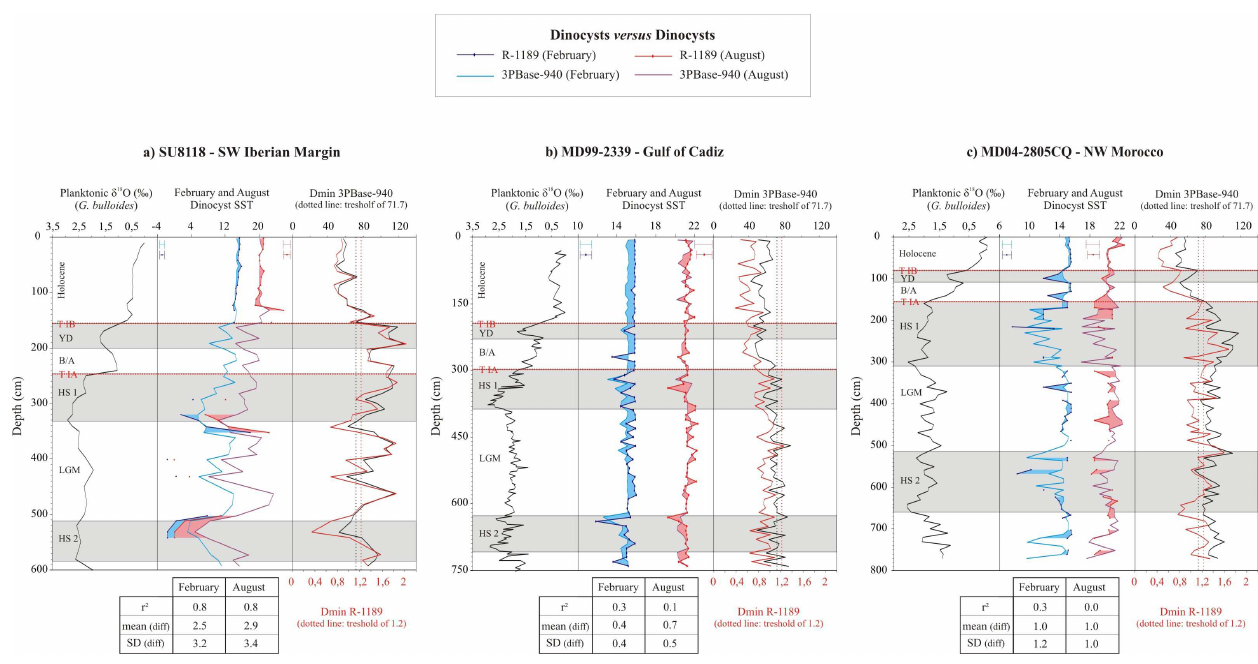
Fig. 3. SU-8118 (a) , MD99-2339 (b) and MD04-2805 CQ (c) . Comparison of quantitative dinocyst SST reconstructions (February and August) from 3PBase-940 and R-1189, in parallel with planktonic δ 18 O ( G. bulloides ). Error bars are shown for the different reconstruc- tions. Dmin, for each transfer function, represents the statistical distance between the closest analogue found by the transfer function and the fossil assemblage. Threshold values of each method are represented by dotted lines. Tables under the graphs show the correlation coeffi- cient between each reconstruction, and the average (mean-diff) and standard deviation (SD-diff) of the differences calculated between each reconstruction. YD: Younger Dryas; B/A: B¨olling-Allerød; HS: Heinrich Stadial; LGM: Last Glacial Maximum; TI: Termination